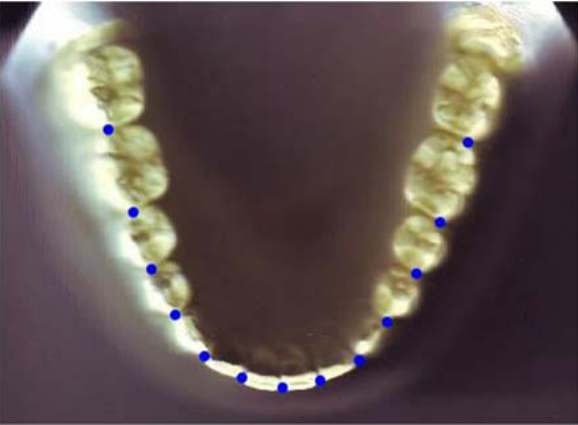
Figure 1. Digitized contact points on a mandibular cast.